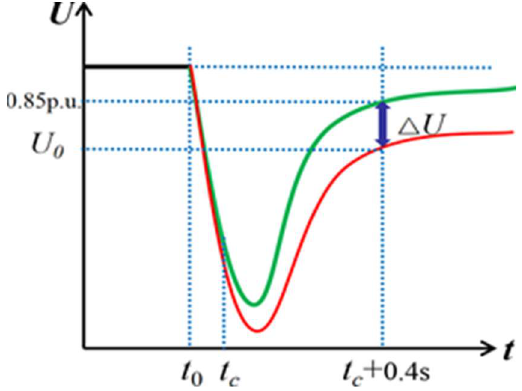
Figure 4. Calculation diagram of var reserve capacity.